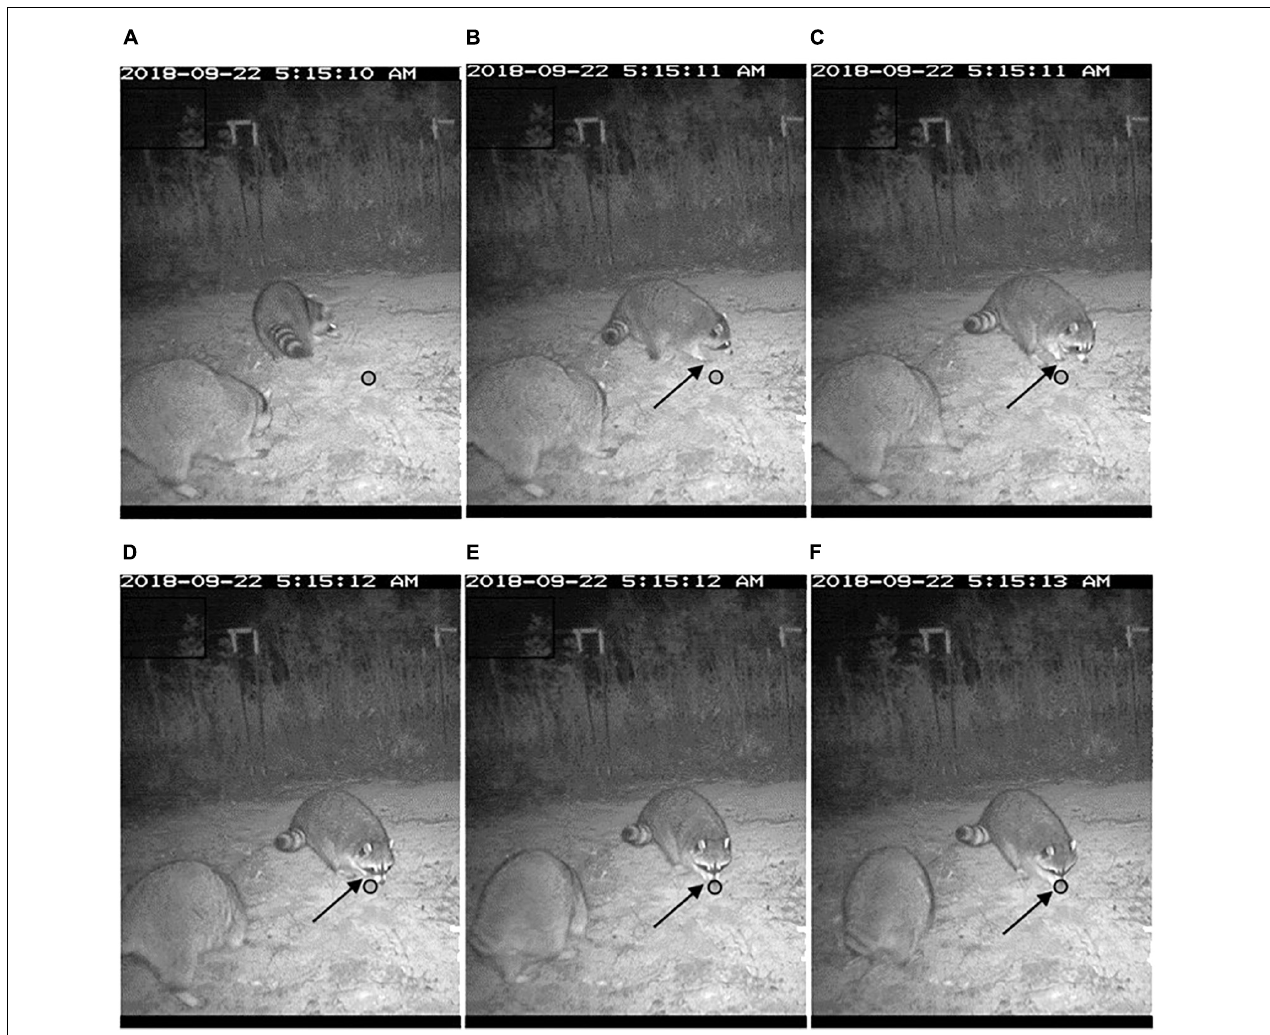
FIGURE 1 | Typical raccoon foraging sequence in finding natural turtle nests and artificial nest cavities: (A,B) approach with nose within 2 cm of surface, (C,D) nose and head move over detected cavity, (D–F) forefoot moves forward into position under nose, (F) excavation begins. Forefoot position indicated by arrows; cavity location indicated by dark